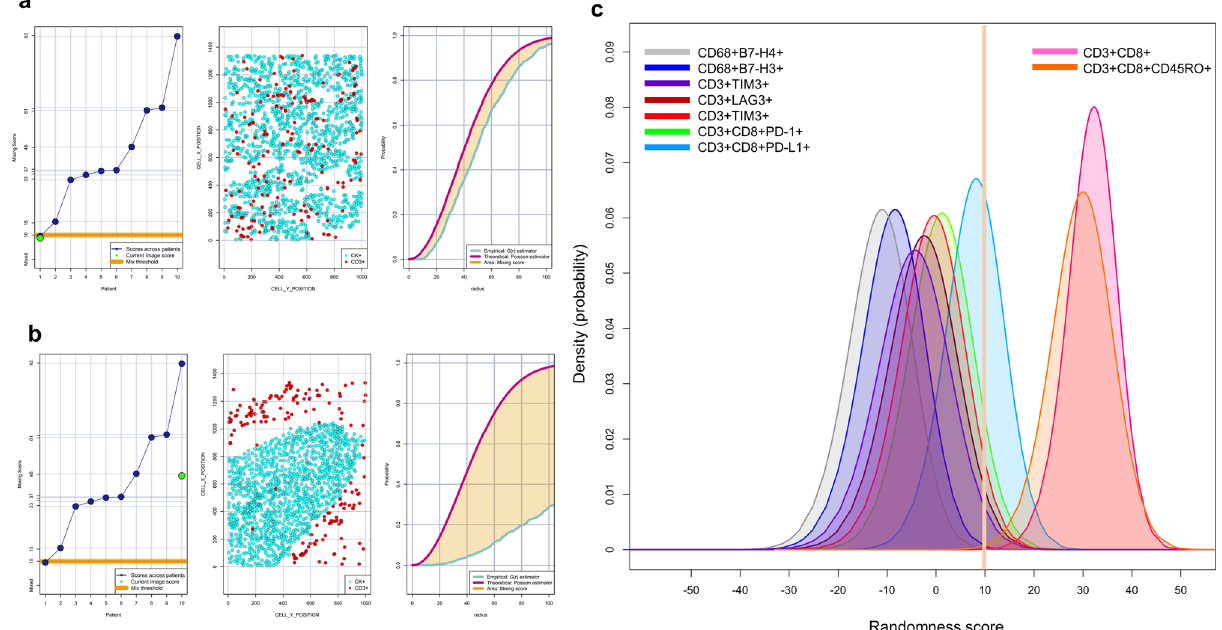
Figure 7. Individual nearest neighbor distance G function and theoretical Poisson curves graphics for the identification of different cellular patterns of distance distribution from CK+ malignant cells to CD3+T-cells and graphic representation of the predominate cell phenotypes that characterize those patterns. (a and b) The scoring scale across the cases and the threshold to be considered mixed or unmixed pattern ( left ), graphic distribution representation of the CD3+T-cells and CK+cells ( middle ), and the nearest neighbor distance G function and theoretical Poisson curves area ( right ). ( a ) Mixed pattern distribution of CD3+T-cells related to CK+cells, ( b ) unmixed pattern distribution of CD3+T-cells related to CK+cells, (c) graphical model showing the characterization of two different groups of interaction between specific phenotypes with malignant cells according their spatial distribution. Suppressor cell phenotypes have scores less than 10 and are characterized by a mixed pattern and more interaction with malignant cells, while cytotoxic T-cells (CD3+CD8+) and cytotoxic memory T-cells (CD3+CD8+CD45RO) have scores greater than 10 and are characterized by an unmixed pattern with less interaction to malignant cells. The images were generated using R studio software version